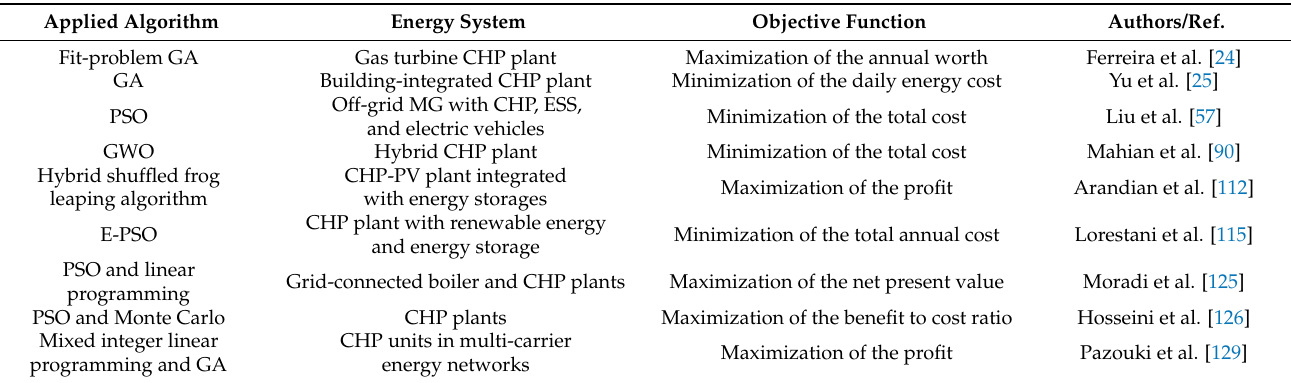
Table 4. Single-objective sizing issues of CHP energy systems.